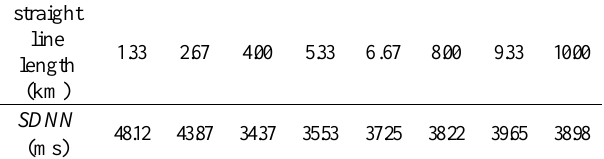
Tab.1. Data of straight line length and SDNN